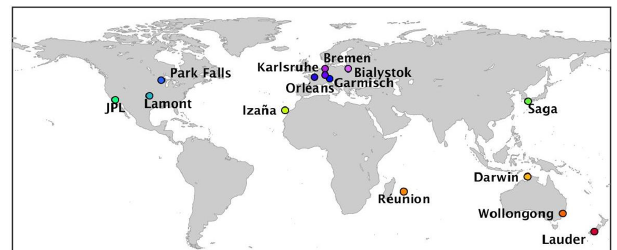
Figure 1. Map of TCCON sites used in this analysis. Site colors are on a spectral color scale in order of latitude, with Northern Hemi- sphere sites designated by cool colors and Southern Hemisphere sites designated by warm colors.